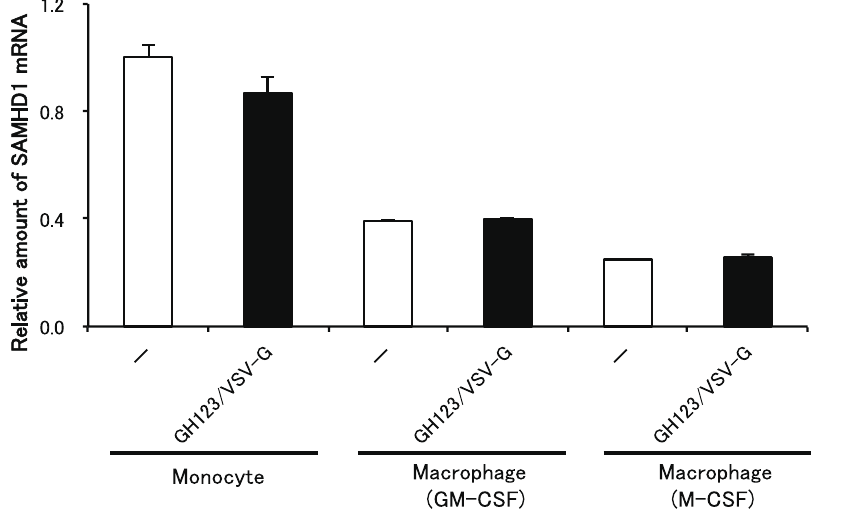
Figure 7. Quantification of SAMHD1 mRNA expression. Monocytes were differentiated into macrophages for 6 days in the presence of GM- CSF or M-CSF. Macrophages or monocytes were treated with or without VSV-G-pseudotyped and Env-defective HIV-2 particles (GH123/VSV-G), and harvested. SAMHD1 mRNA expression levels were detected by real-time RT-PCR and normalized against GAPDH. Data are shown as mean 6 SD.